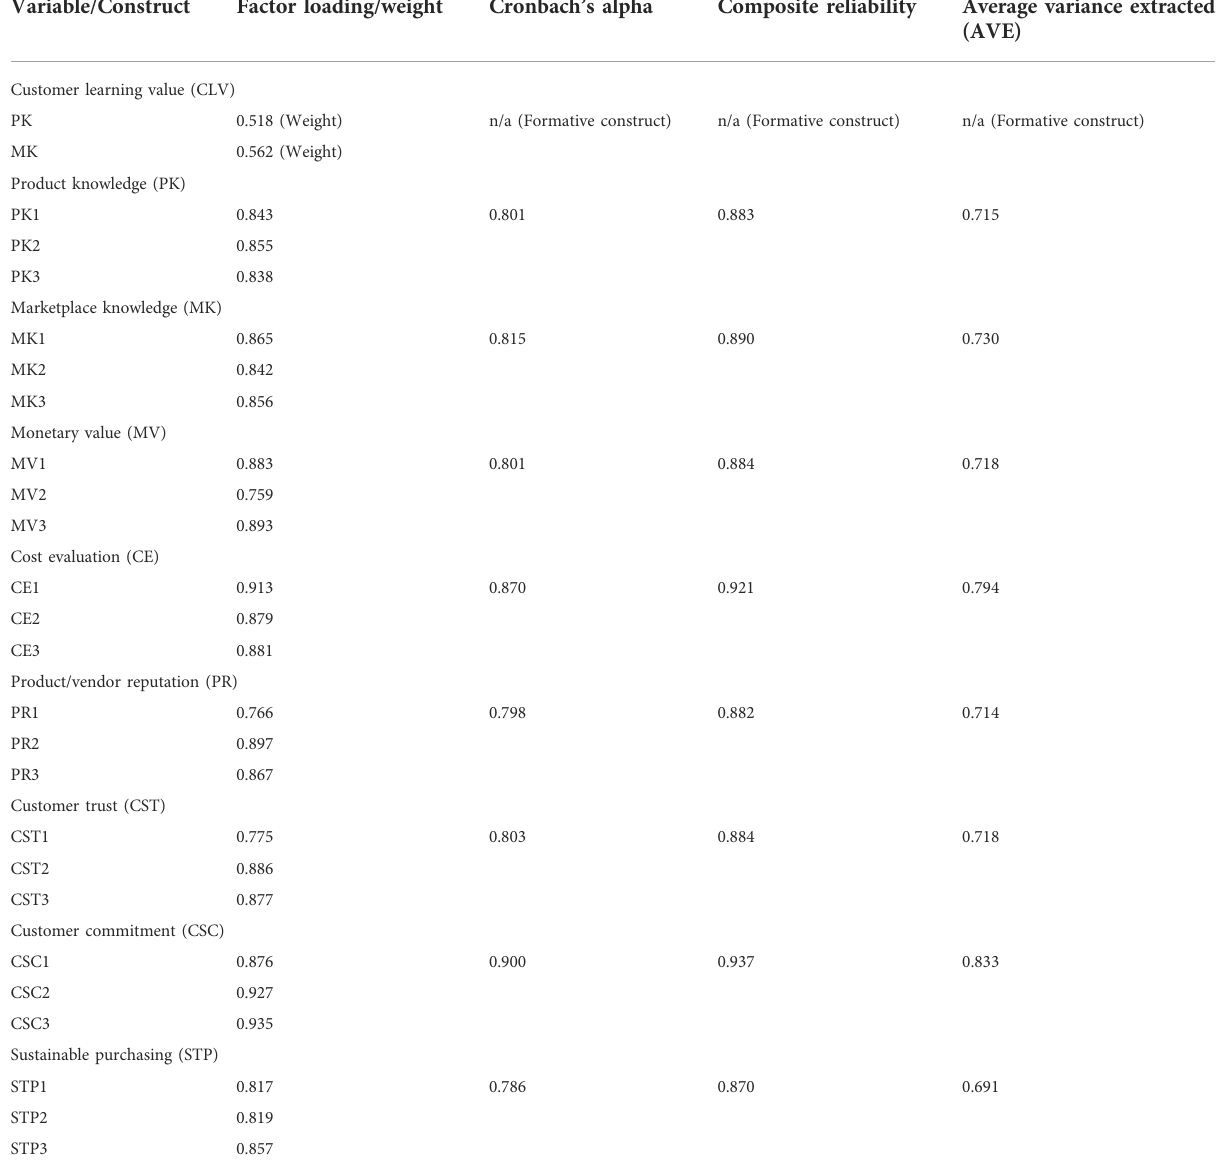
TABLE 3 Construct reliability and validity of the model AVE, average variance